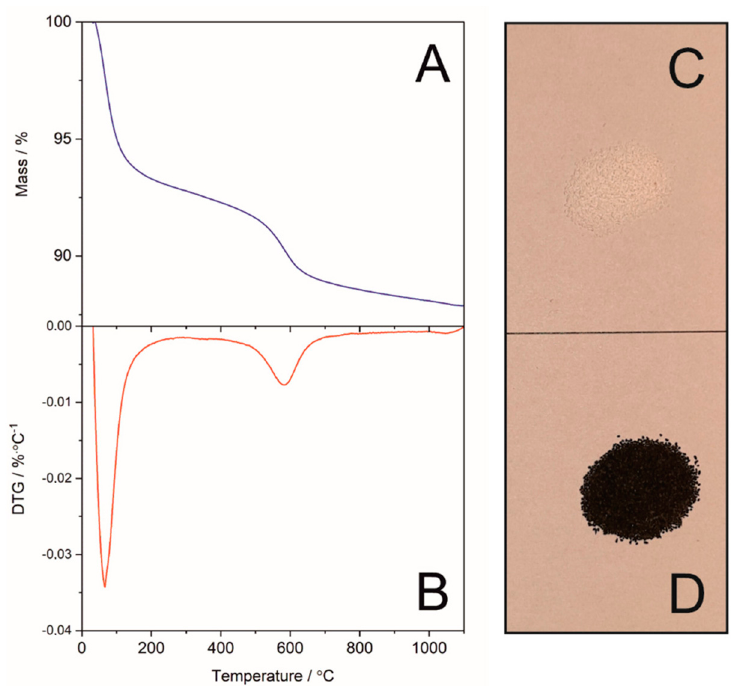
Figure 7. Thermogravimetric (TG) analysis of the 3Al-TIE sample after four catalytic runs. ( A ) TG profile, ( B ) DTG profile, ( C ) photographs of fresh and ( D) used (after 4 catalytic runs) 3Al-TIE catalysts.